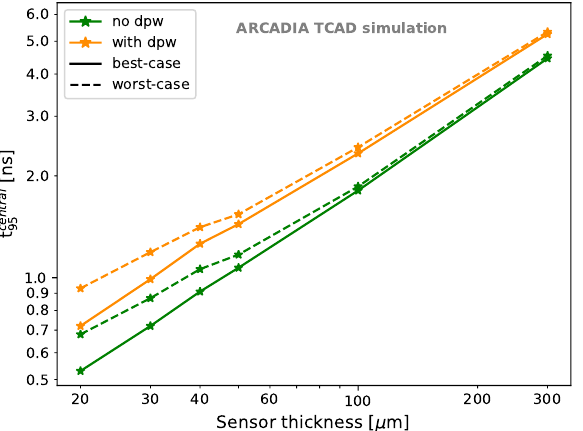
Figure 24. t central as a function of the sensor thickness for best-case and worst-case scenarios. 95